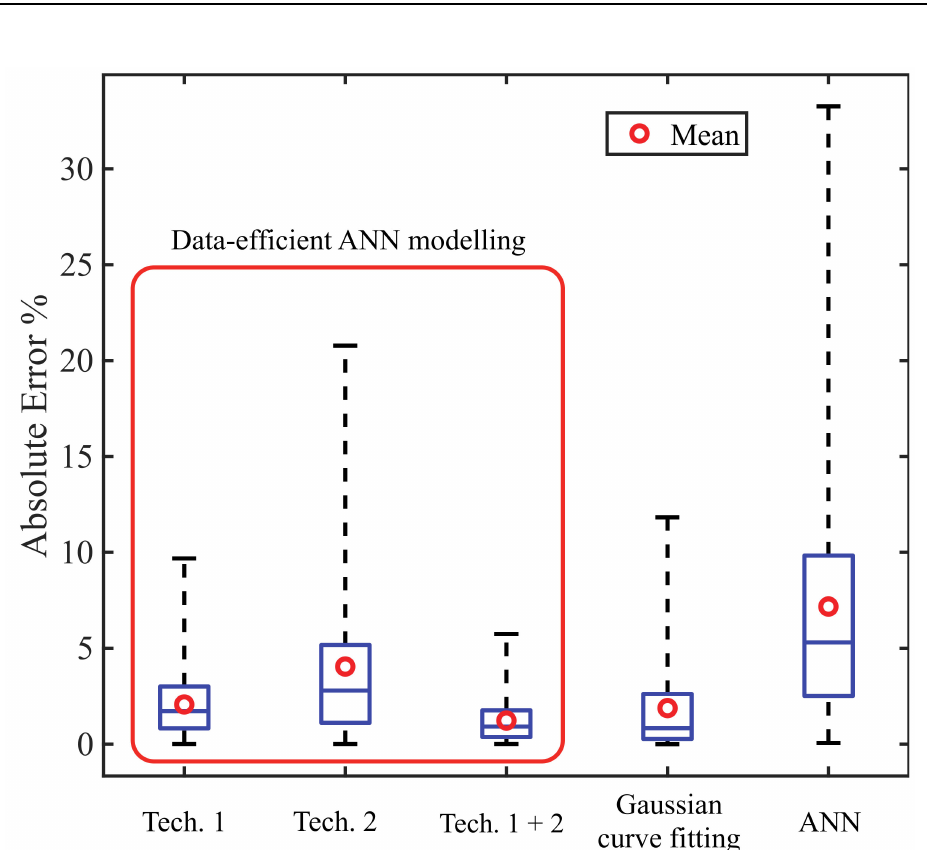
Figure 3. Graphical summary of the prediction results in absolute percent error for the testing single-track profiles in Cold Spray Additive Manufacturing (CSAM). The proposed data-efficient Artificial Neural Network (ANN) model is shown as Tech. 1 + 2 data-efficient